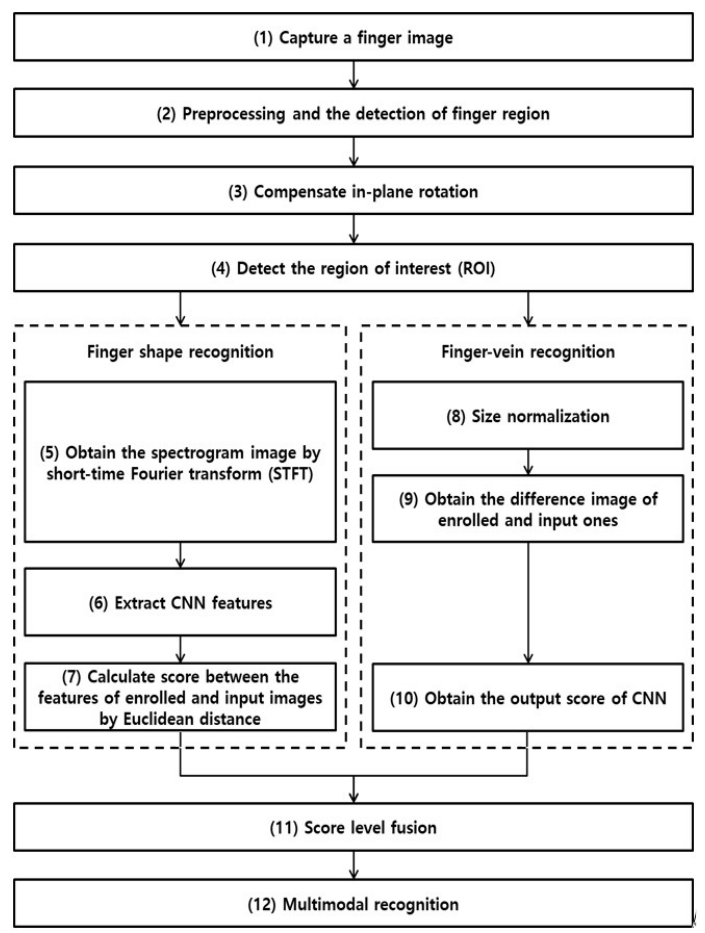
Figure 1. Flowchart of the proposed method.